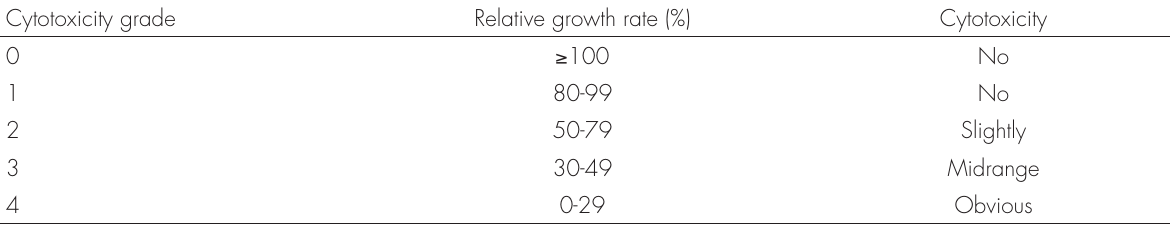
Table I. Evaluation of